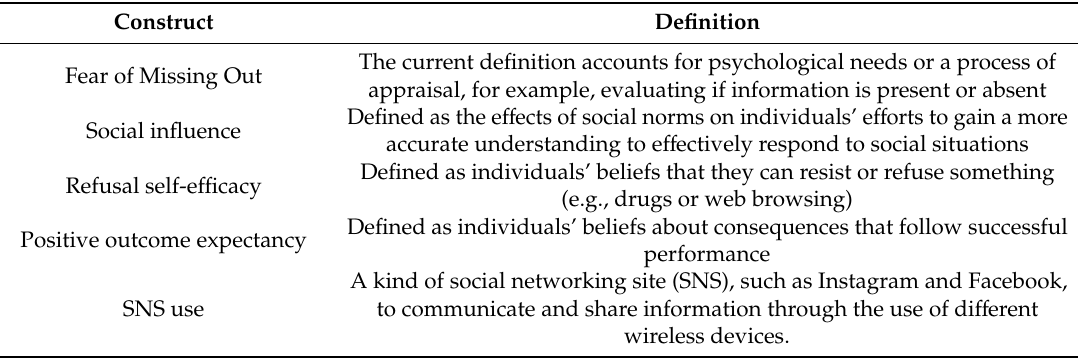
Table 1. The constructs and definitions of the hypothesized